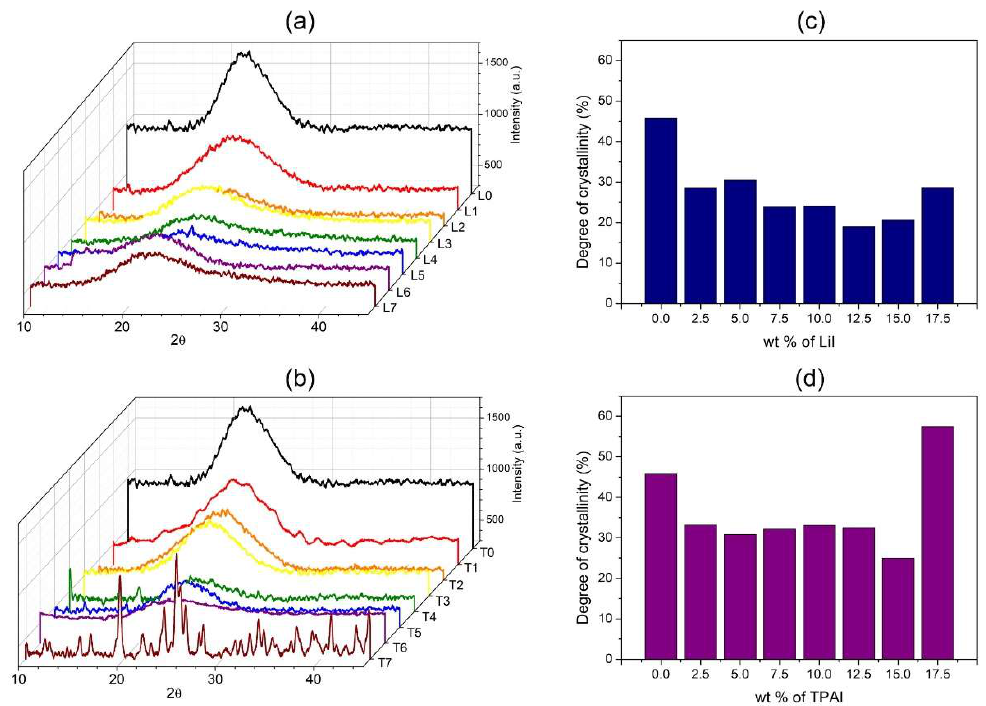
Figure 6. XRD di ff ractograms of ( a ) LiI and ( c ) TPAI and degree of crystallinity of ( b ) LiI and ( d ) TPAI based electrolytes.